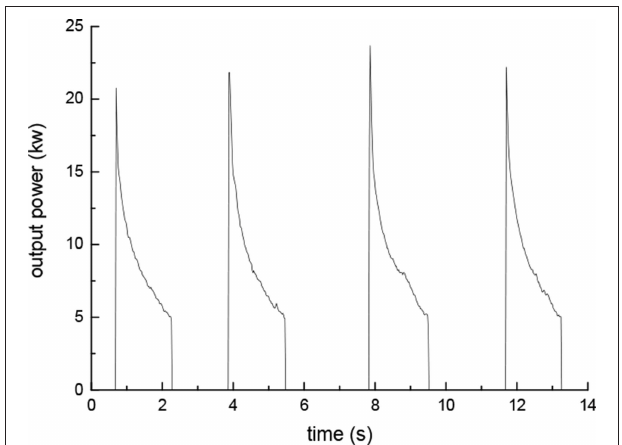
FIGURE 14 | Output power.